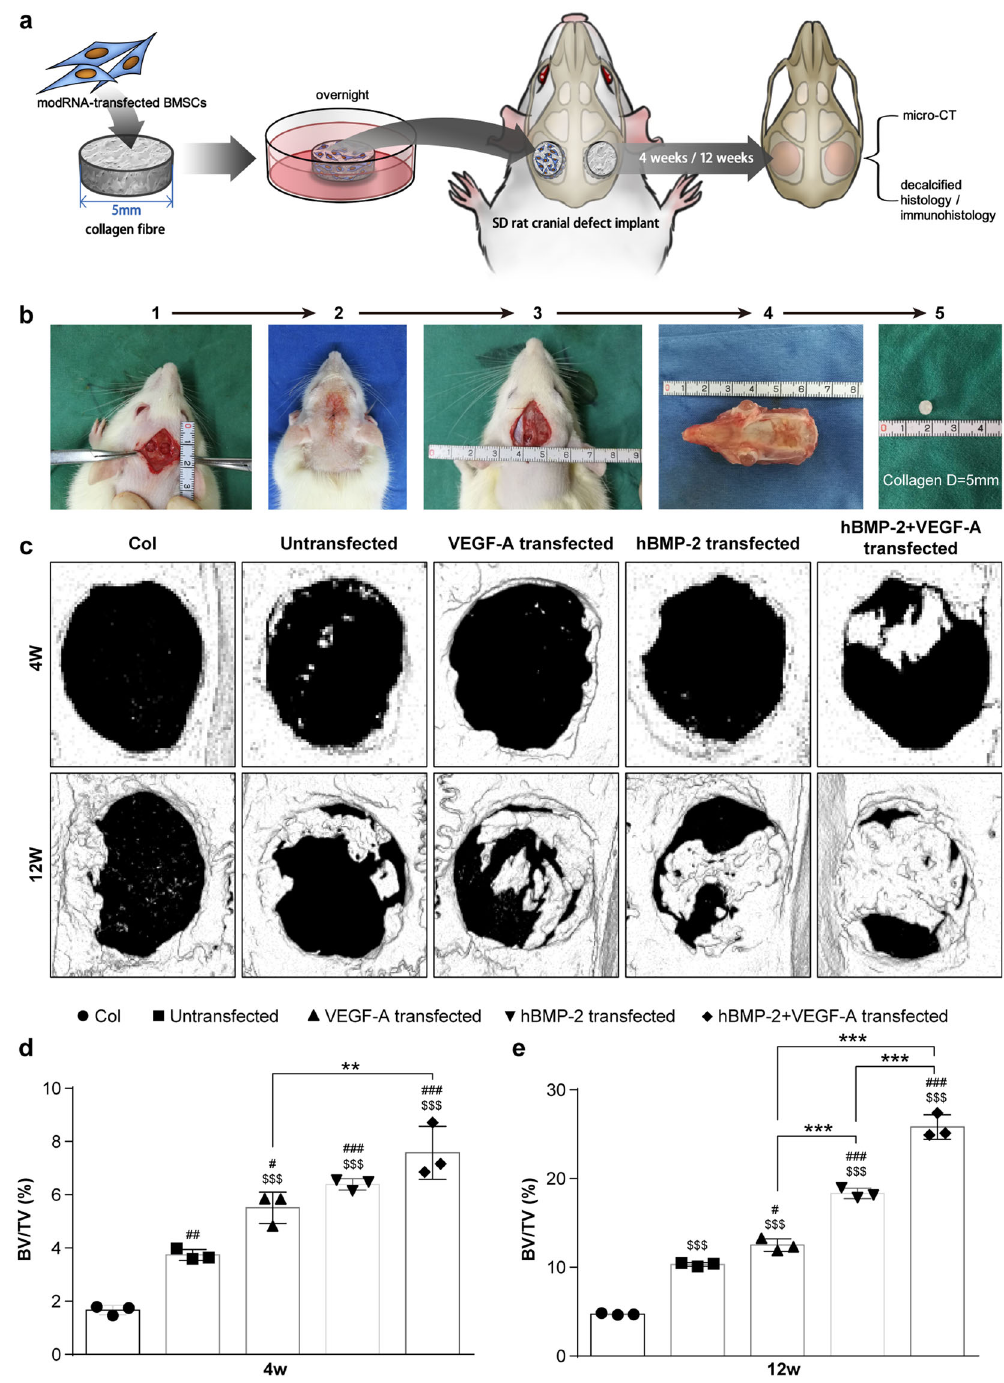
Fig. 3 modRNA treated BMSCs combined with biomaterials enhance bone healing in rat cranial defect model. (a-) Schematic of experimental design ( a ) and cranial defect surgery process ( b ). c Representative images reconstructed from 3D μ CT scans reveals bone tissue regeneration at 4 and 12 wks after treatment. d , e Quanti fi ed bone volume fraction (BV/TV) of regenerated bone at 4 wks ( d ) and 12 wks ( e ) post-implantation. Differences between modRNA treatments and control group were assessed by one-way ANOVA followed by Tukey ’ s multiple comparison. Dollar ($) indicate difference between acellular collagen scaffold group and other four groups. Hash (#) indicate difference between non-transfected and transfected groups. Asterisk (*) indicate difference among modRNA transfection groups. (Values are expressed as mean ± SD, $/#/ * p < 0.05, $$/##/ ** p < 0.01, $$$/###/ *** p < 0.001). transfected BMSCs and surgically implanted at the orthotopic site According to µCT scans, we found the combinatorial treatment (Fig. 3a, b). The rats were sacri fi ced at 4 and 12 weeks (wks) post- of 1B1V modRNA was most capable of generating new bone operation, where the degree of bone healing was evaluated tissue deposition that fractionally fi lled the defect space at 4 and through histology and micro-computed tomography (µCT) scans 12 wks following transplantation (Fig. 3c). Quantitative analysis to calculate percent bone volume (BV/TV). of μ CT scans revealed the 1B1V modRNA treatment group